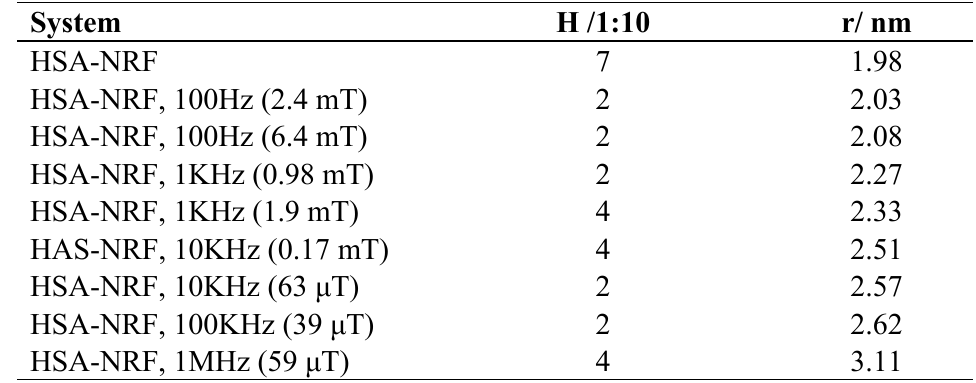
Table 4. The H value and the distance, r, between donor and acceptor of HSA with NRF in the absence and presence of different of